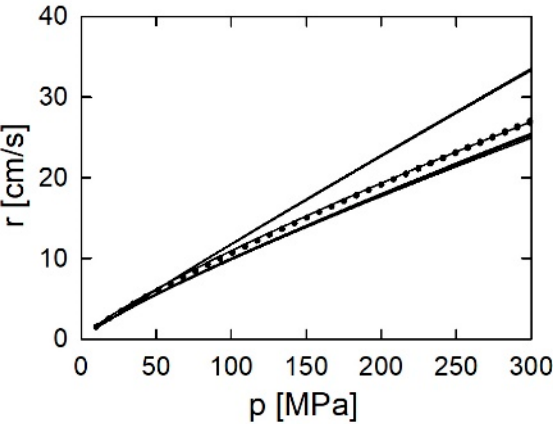
Figure 13. Burning rate dependence on pressure for JA-2 propellant (data from Table 2).